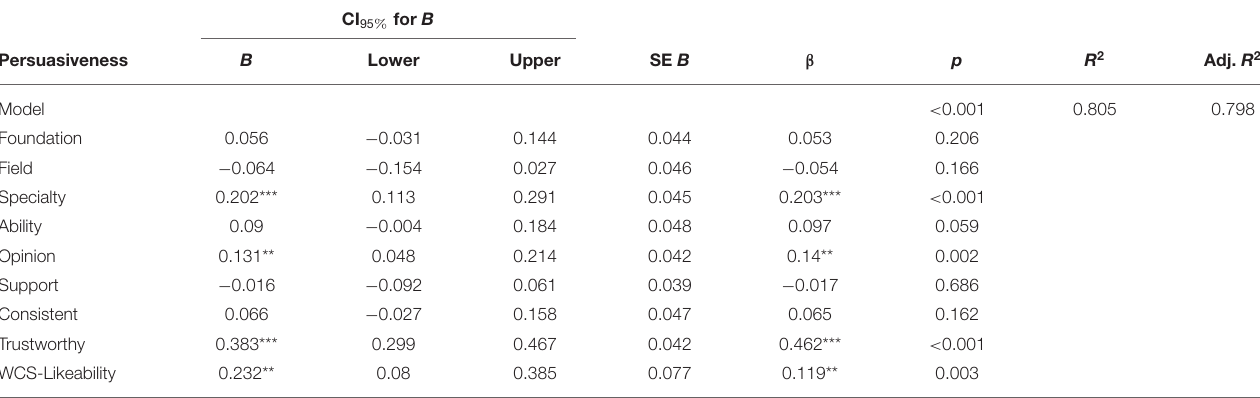
TABLE 8 | Multiple regression predicting persuasiveness from continuous expert persuasiveness expectancy (ExPEx) ratings and witness credibility score (WCS) for likeability. CI 95 % for B